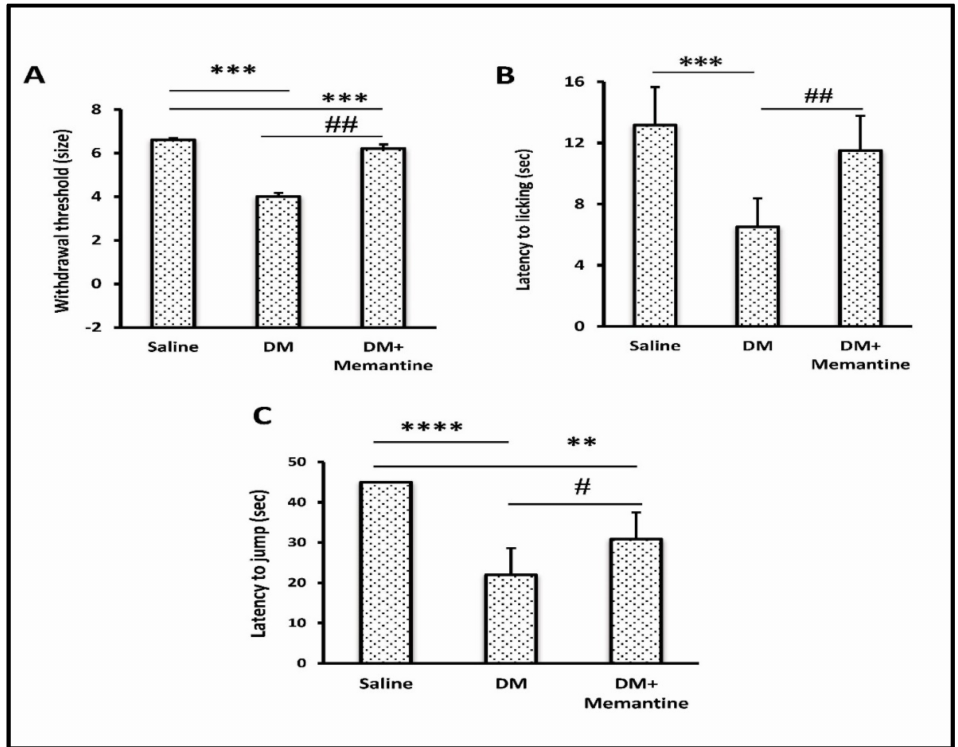
Figure 2. Effect of memantine on allodynia and hyperalgesia. Diabetic mice were tested for ( A ) the von Frey test, ( B ) latency to licking (sec) and ( C ) latency to jump. Data are the mean ± SDM and analyzed by one-way ANOVA and Tukey’s tests. DM: diabetes mellitus mice, SDM: standard deviation of the mean. ** p < 0.01, *** p < 0.001, and **** p < 0.0001, versus the saline group; # p < 0.05 and ## p < 0.01 versus the DM